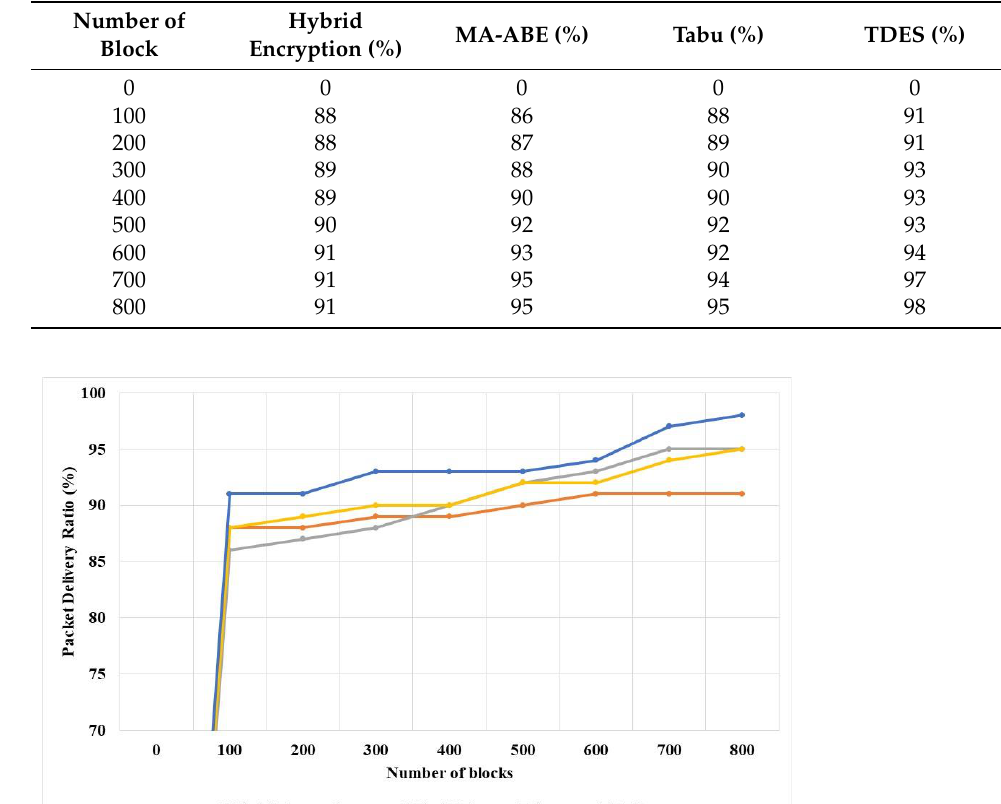
Table 12. Packet delivery ratio of TDES and comparison with existing techniques.